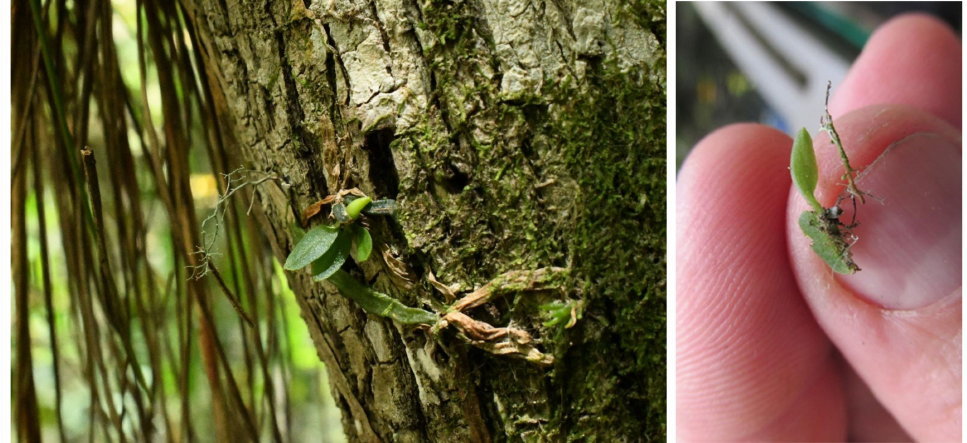
Figure 2. Campylocentrum pachyrrhizum seedlings are often found with 2–3 leaves that will fall off as the orchid grows; some leaves have been observed to remain after years. Although it is unknown how large the orchid must be before the leaves fall off, all the large individuals do not have leaves